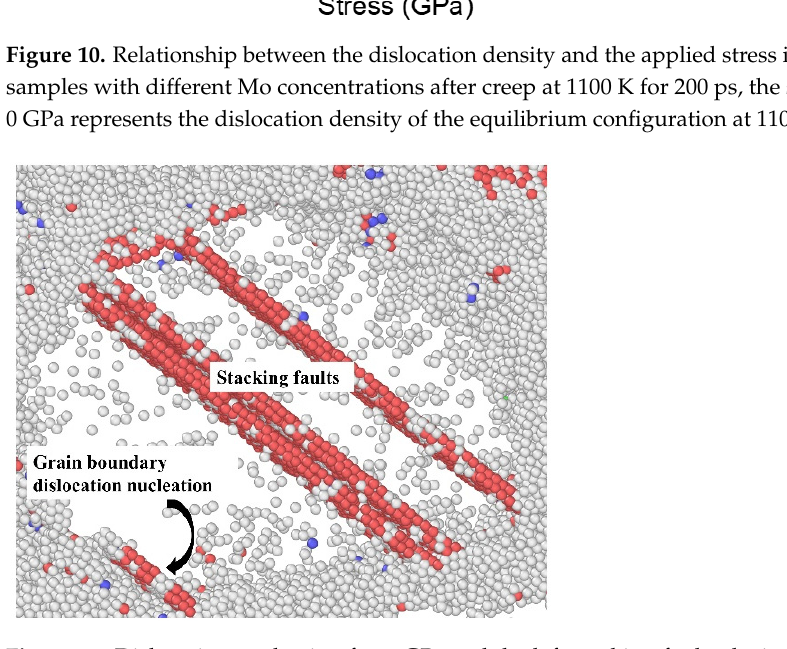
Figure 11. Dislocation nucleation from GBs and the left stacking faults during creep deformation under an applied stress of 1.6 GPa at 1100 K. The snapshot is from the segregated sample with 6 at.% Mo atoms and 𝑑 = 10.9 nm, in which the perfect fcc atoms are not shown for clarity.